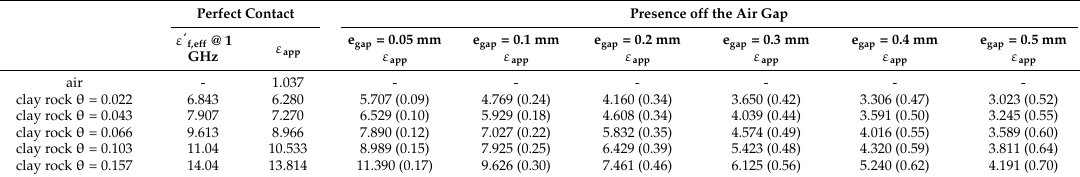
Table 2. Onset method. Comparison between apparent permittivity for the perfect contact configuration and real part of the effective permittivity at 1 GHz. Apparent permittivity obtained for different values of the air gap, values in brackets are the relative error between expected (e.g., perfect contact) and obtained values.